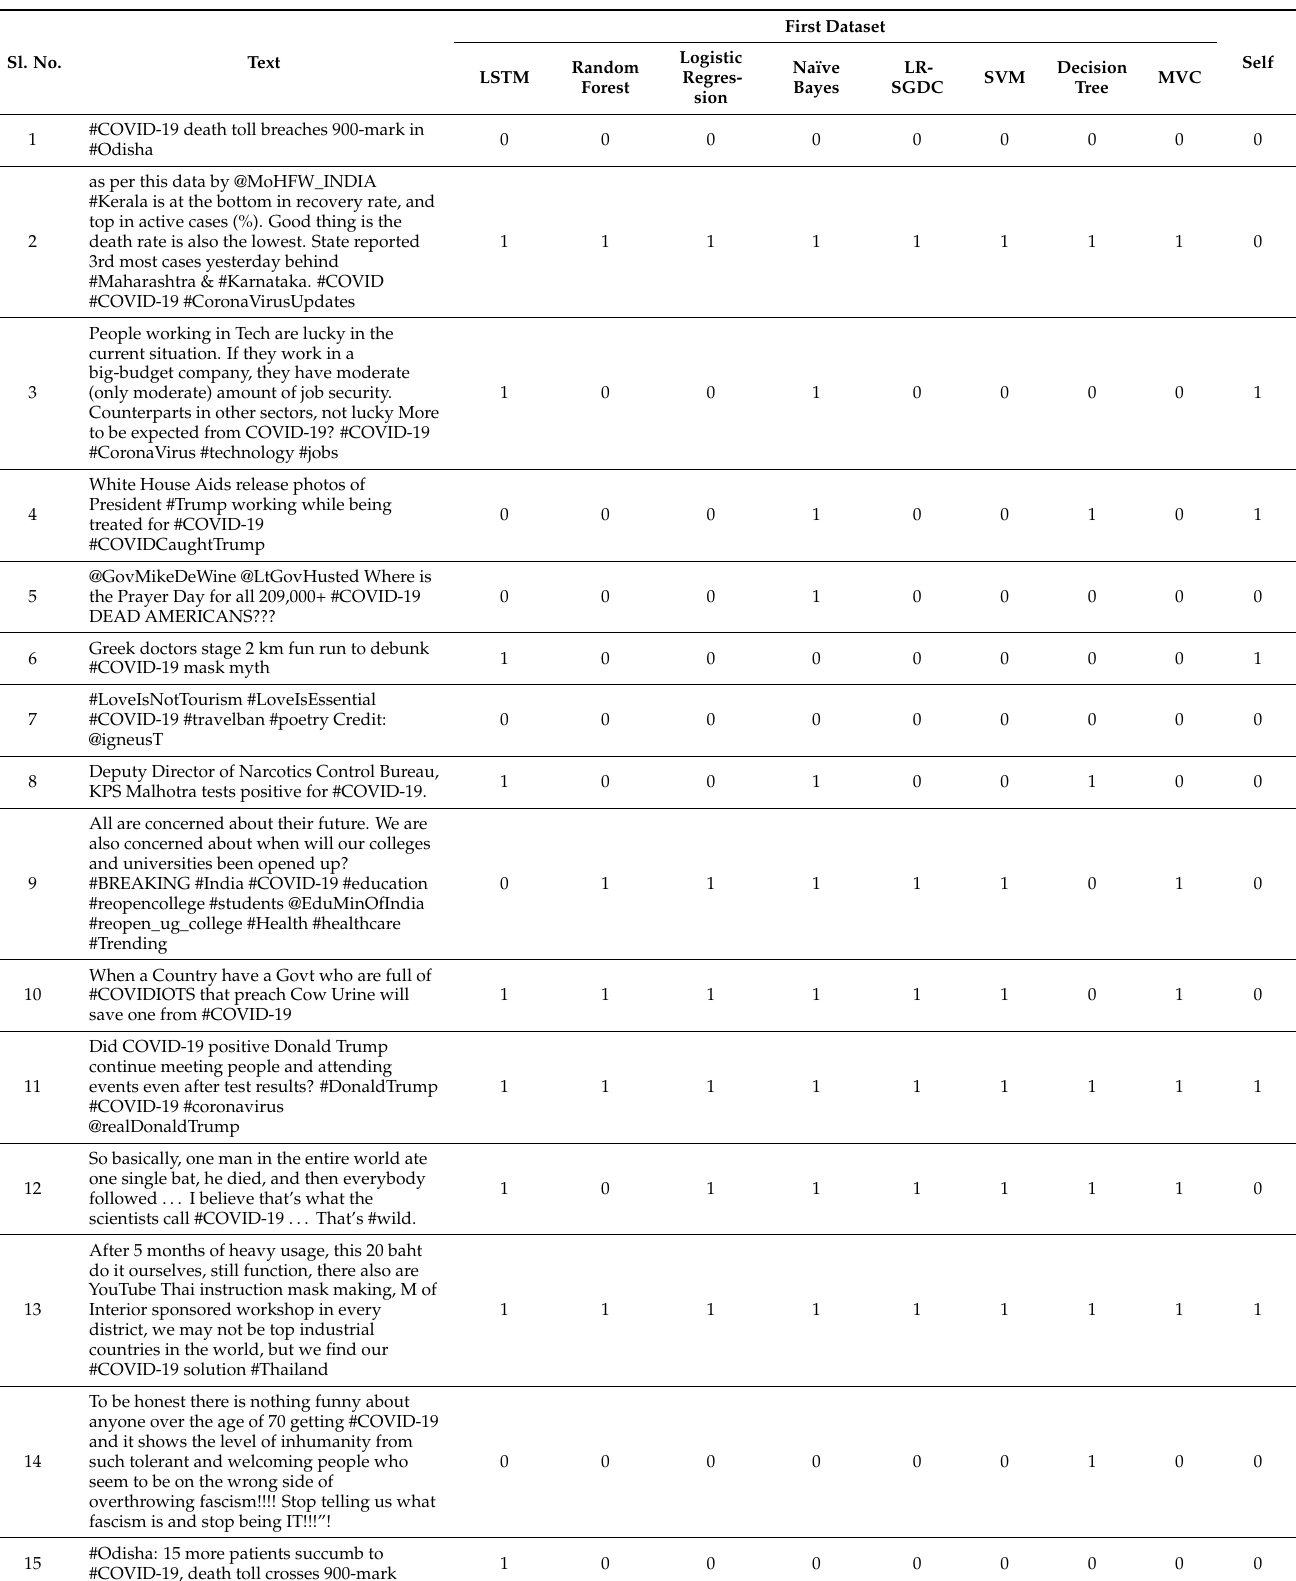
Table 8. Prediction of mined tweets by the various classifiers trained with first